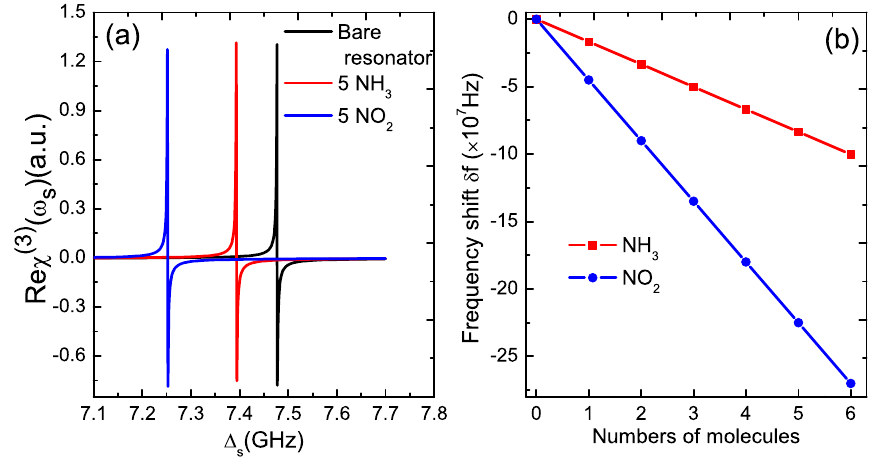
Figure 5. ( a ) The optical Kerr coefficient with and without landing the external molecules on the surface of the GNR resonator. The black curve shows the original resonance of the resonator; the red curve indicates that after landing five NH molecules, and the blue curve 3 shows that after depositing five NO molecules; ( b ) The relationship between the frequency 2 shift of the resonator and the number of deposited molecules. The other parameters used are the same as Figure